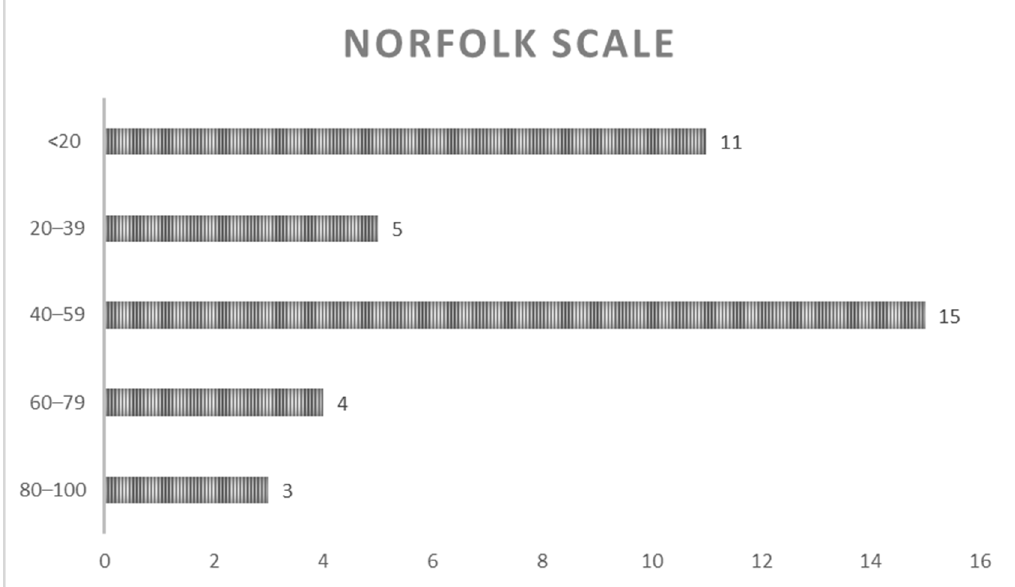
Figure 3. Norfolk QoL-DN questionnaire scores. This figure represents the number of patients who have obtained scores within each range; lower scores represent better results.